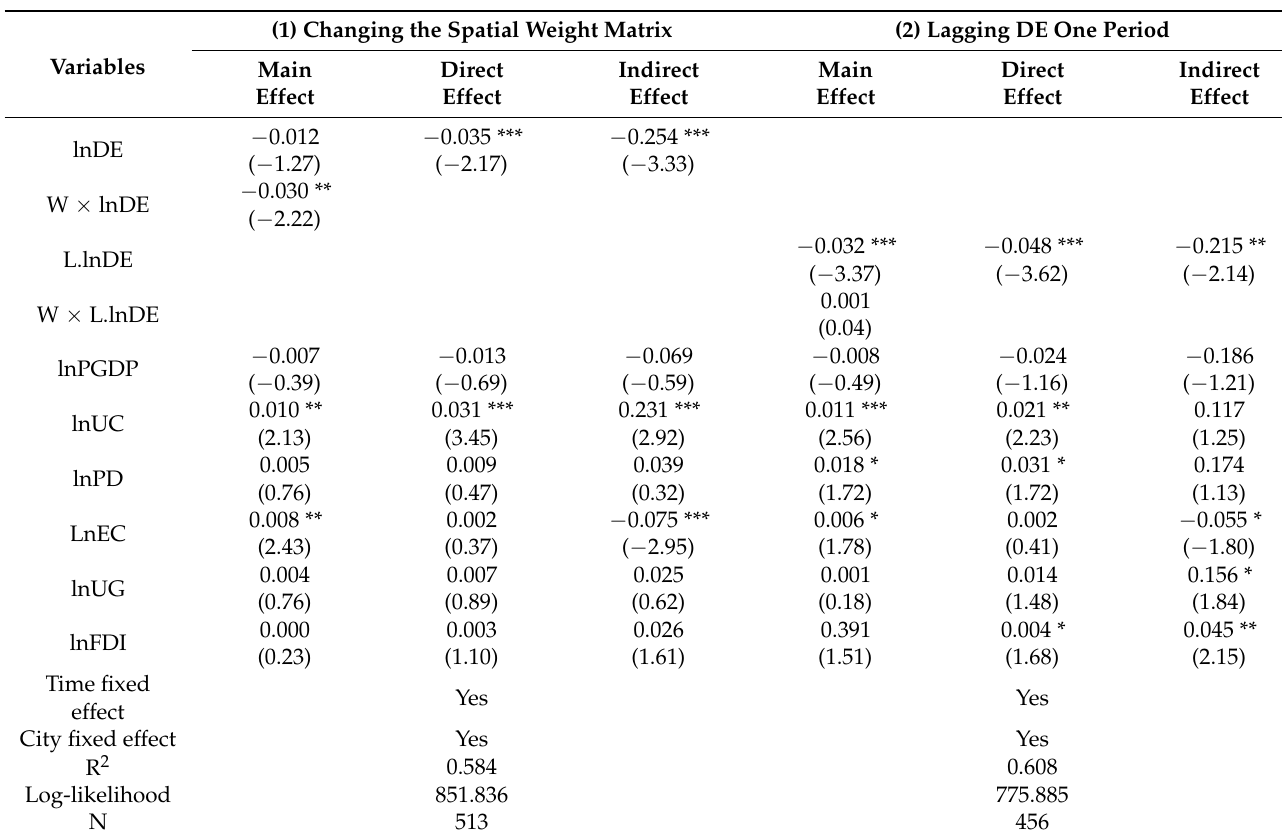
Table 9. The results of the robustness